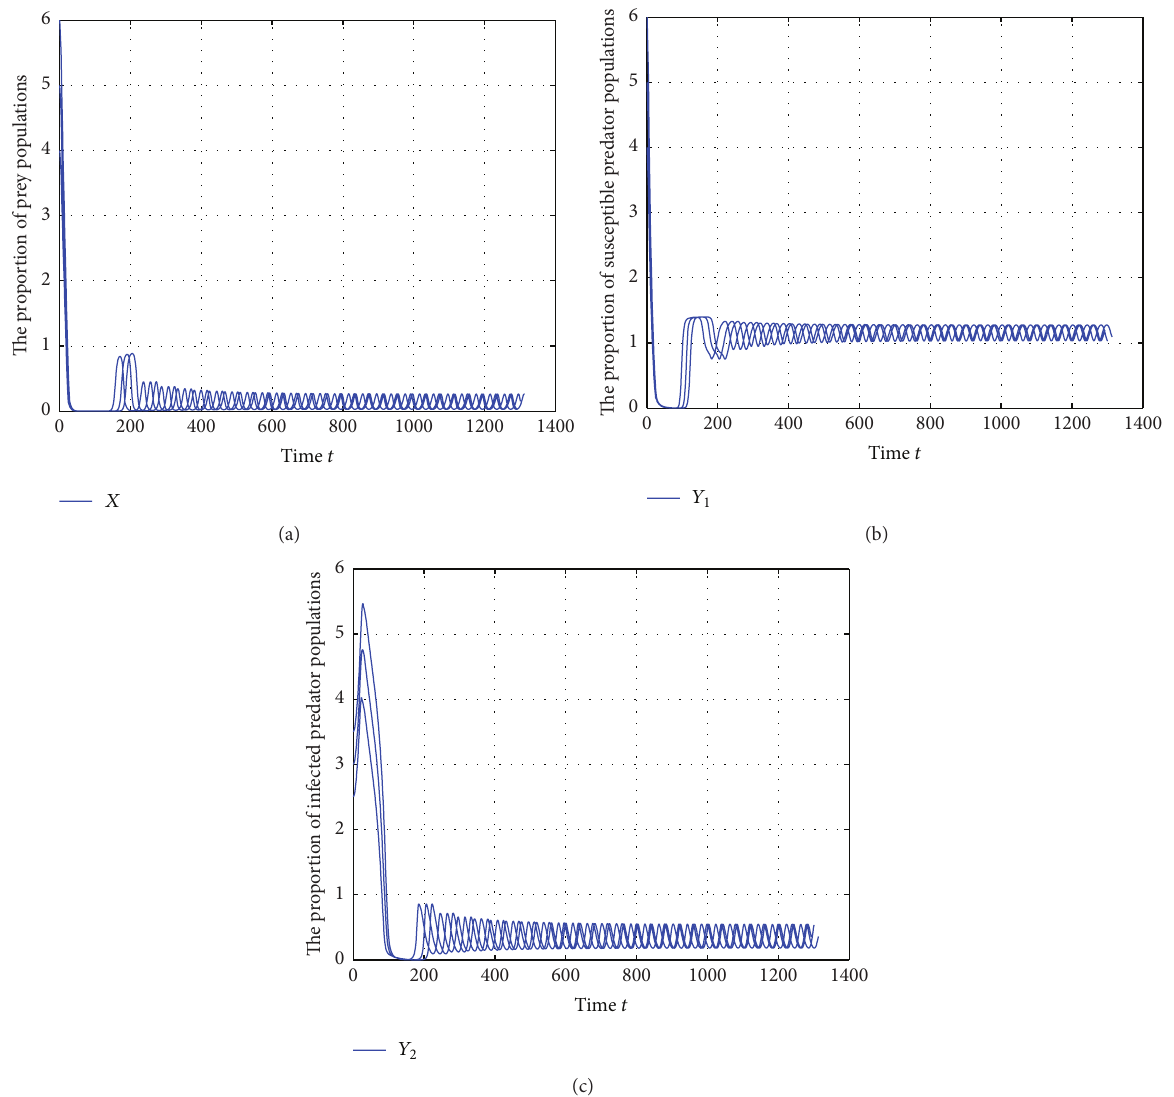
Figure 2: Hopf bifurcation around the interior equilibrium of system